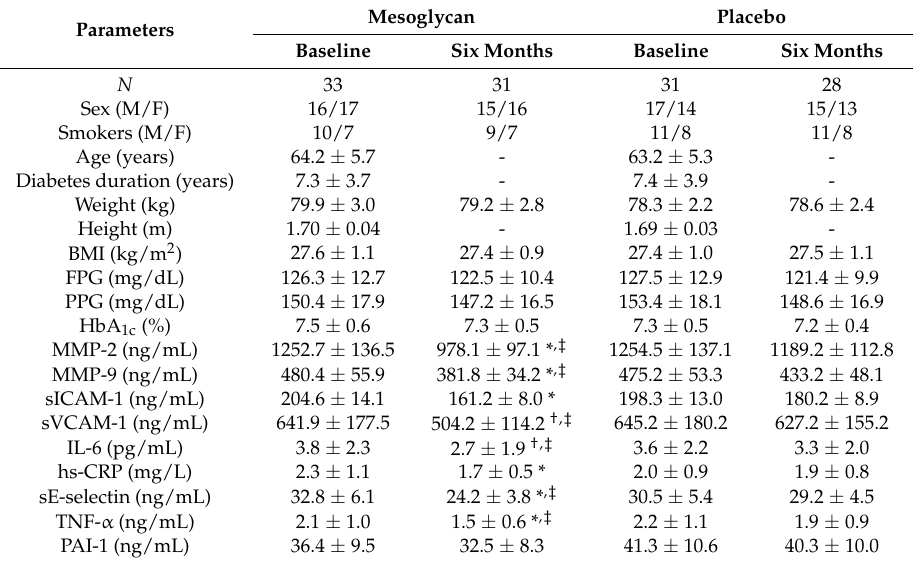
Table 1. Results at baseline and at the end of the study regarding biochemical